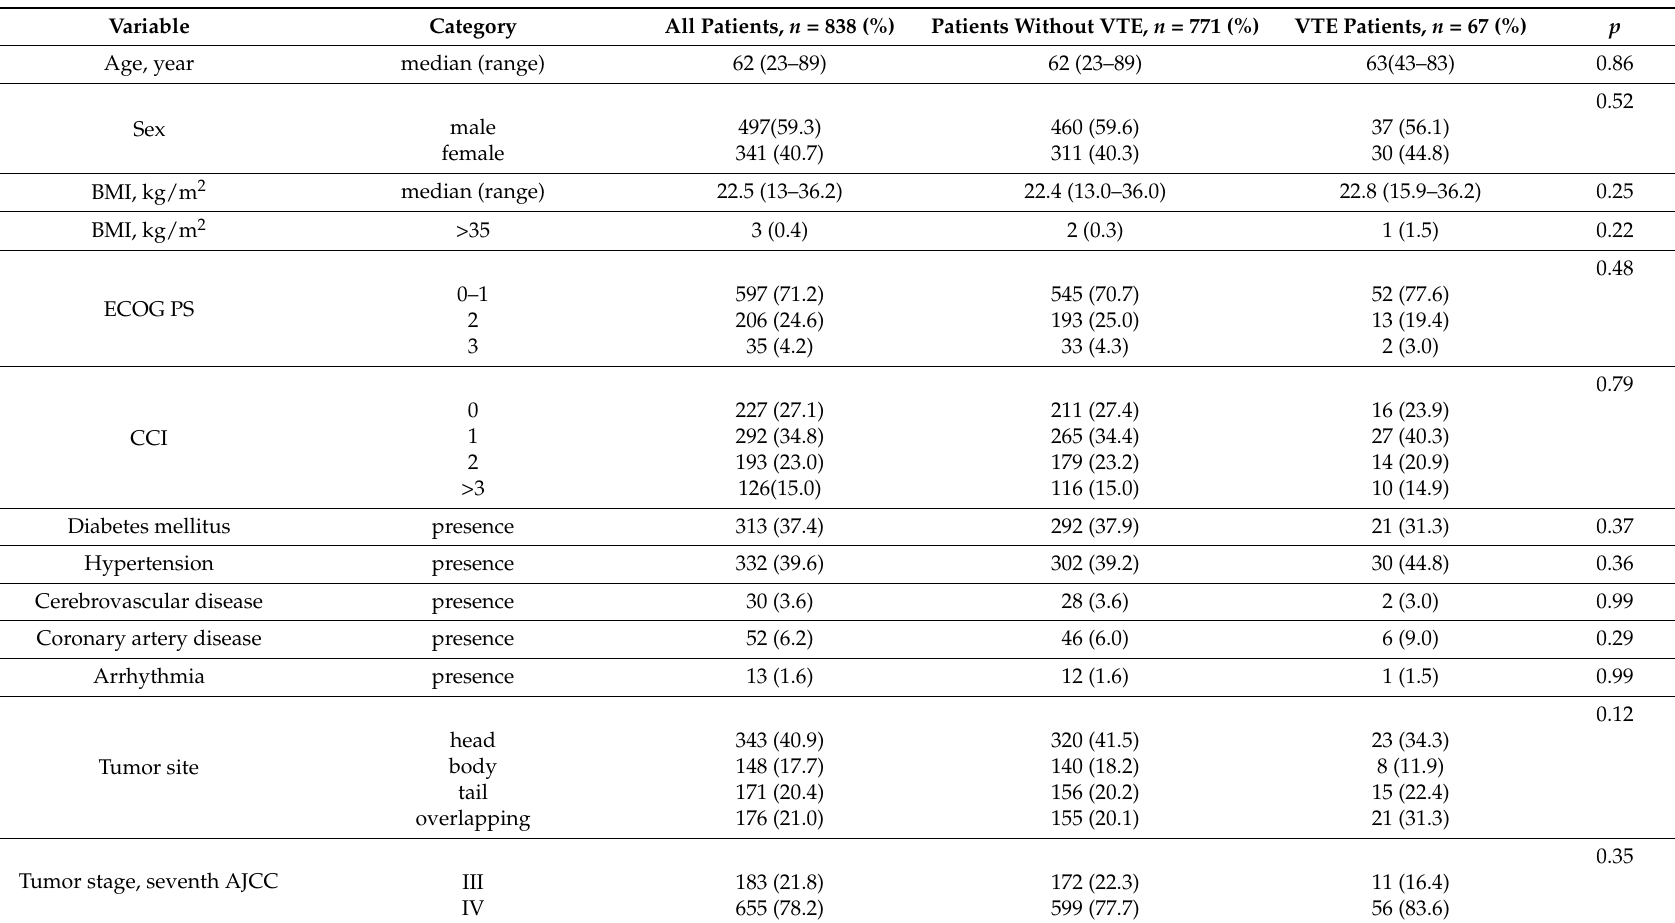
Table 1. Patients’ demographic